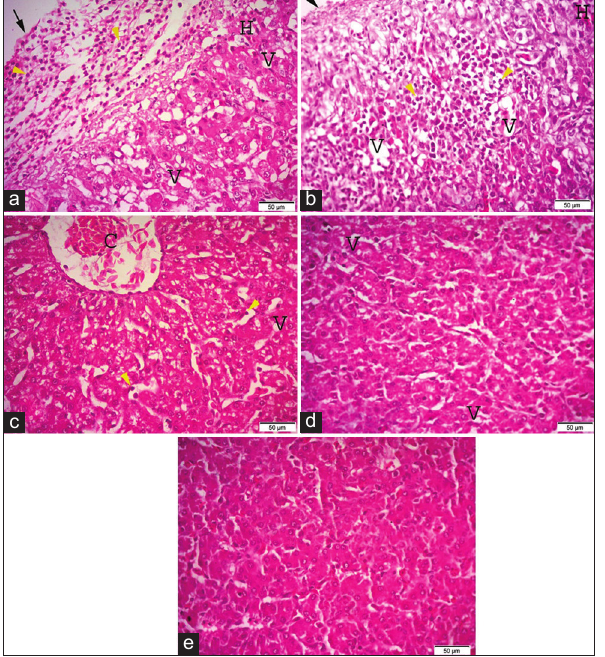
Figure-2: Photomicrographs of hematoxylin and eosin (H&E) stained sections of the heart, (a) the heart of G1 (broilers supplemented with 0.5 g/L Bacillus subtilis ) showing pericarditis (arrow), vaculation of myocardial cells (V). (b) The heart of G2 (broilers supplemented with 1.0* g/L B. subtilis ). (c) The heart of G3 (broilers supplemented with 1.5 g/L B. subtilis ). (d) The heart of G4 (broilers supplemented with 2.0 g/L B. subtilis ). (e) The heart of G5 (control group). H&E (40×). Bar 50 µ